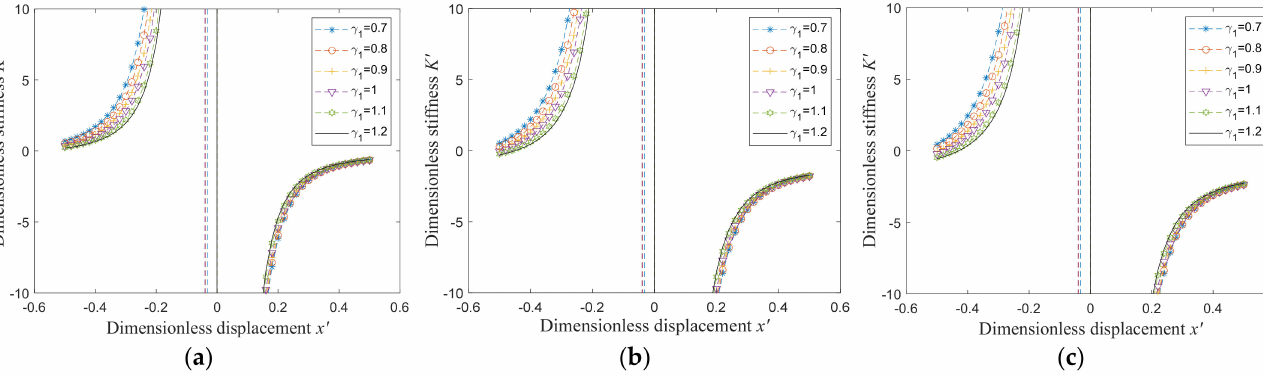
Figure 6. Dynamic stiffness curves of systems with the various values of γ 1 : ( a ) α = 0.6, γ 2 = 0.8; ( b ) α = 1.0, γ 2 = 0.8; ( c ) α = 1.2, γ 2 =